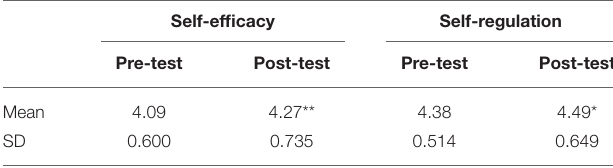
TABLE 8 | Results from the pre- and post-test questionnaires for self-efficacy and self-regulation scales ( n = 145).